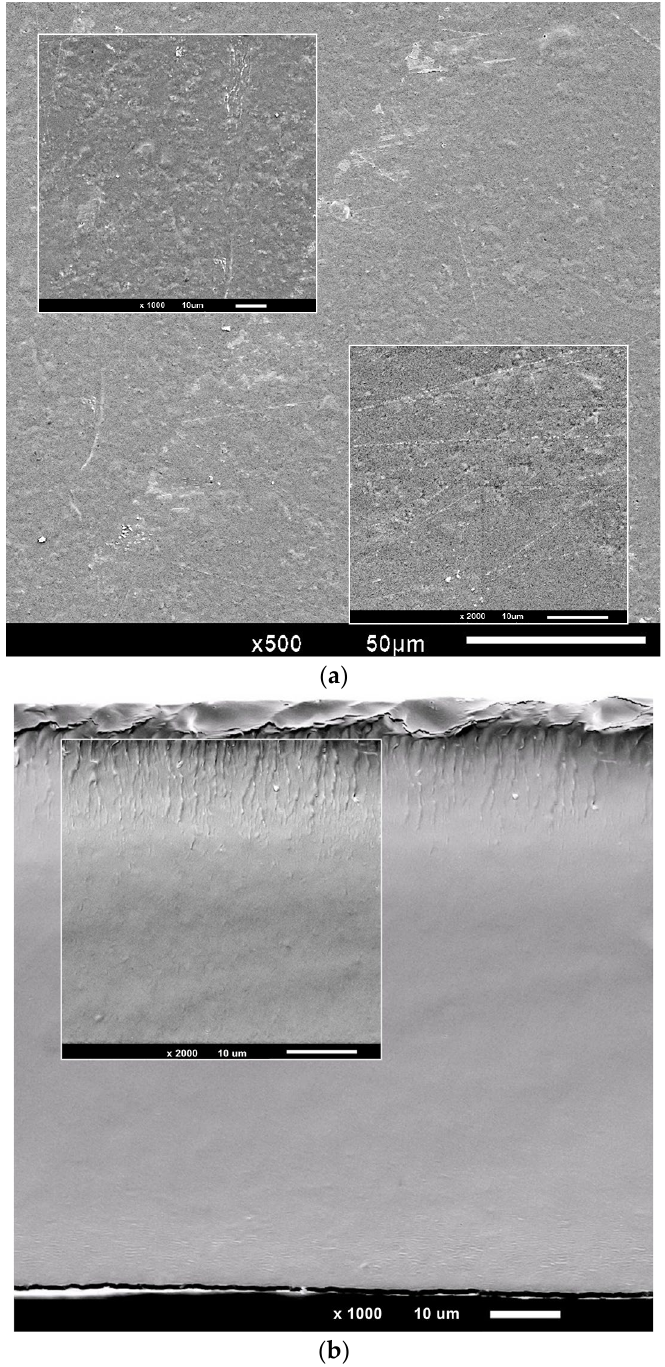
Figure 5. SEM micrographs of the ( a ) surface ( b ) cross-sectional morphology of the starch-PEJP film. The produced film presented, in general, a homogeneous surface (Figure 5a), with some irregularities associated with the drying stress, which may be caused by the stress induced in the polymer chains upon solvent evaporation. On the other hand, the cross- sectional analysis of the starch-PEJP coating (Figure 5b) evidenced a compact, soft and uniform structure without vesicles or pores. These results suggest that PEJP was compatible with the other polymer components (IS and SS) and plasticizer (glycerol), resulting in a cohesive and stable three-dimensional